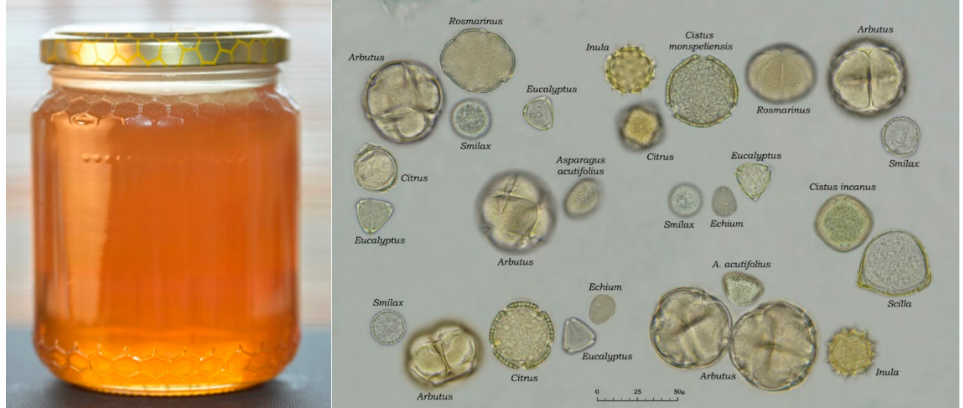
Figure 3. A jar of Sardinian bitter honey and its common melissopalynological spectrum (Photos: Nicola Palmieri).